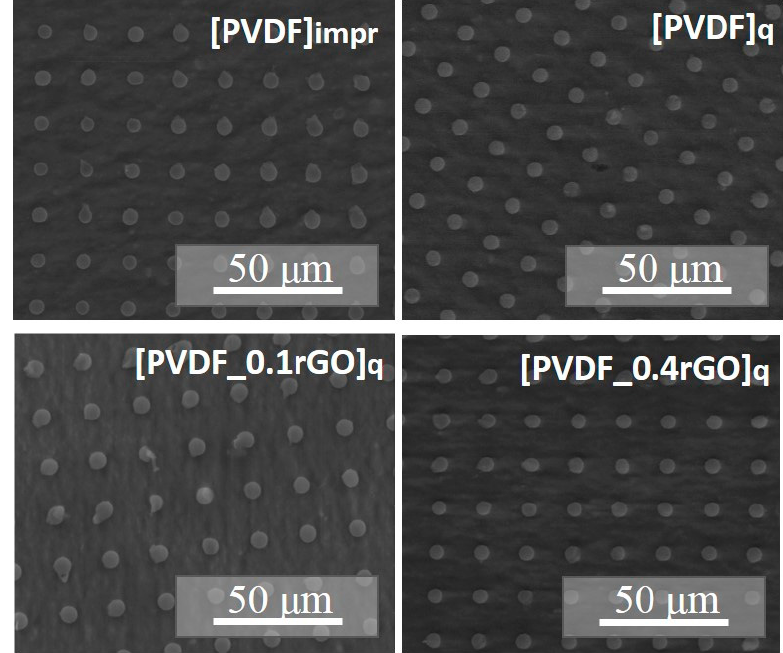
Figure 5. SEM images of the PVDF micropillar arrays imprinted and quenched in glycerol with and without the rGO filler.